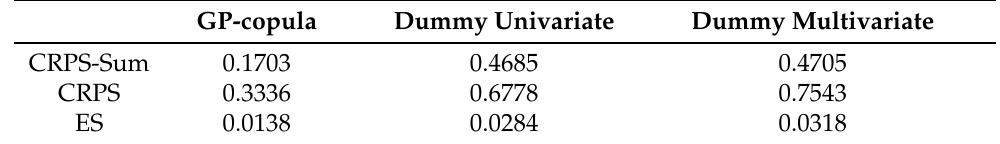
Table 2. This table illustrates the results from dummy models on the taxi dataset and compares their performance with GP-copula based on CRPS-Sum, CRPS, and ES. In contrast to the exchange-rate dataset, it is not feasible to cross-check these quantities in higher